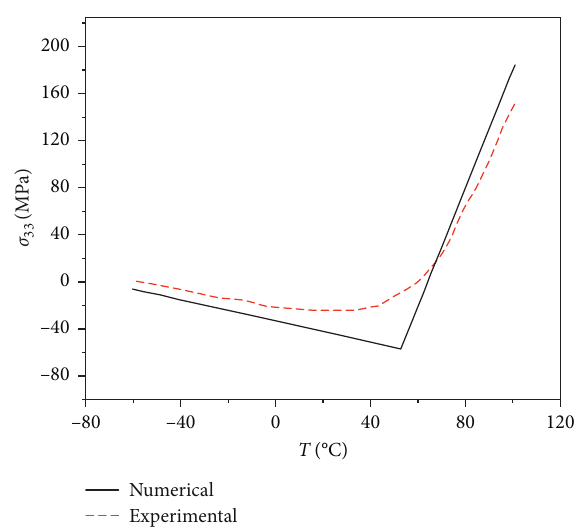
Figure 7: Characteristics of constraint heating compared between numerical simulation and experimental